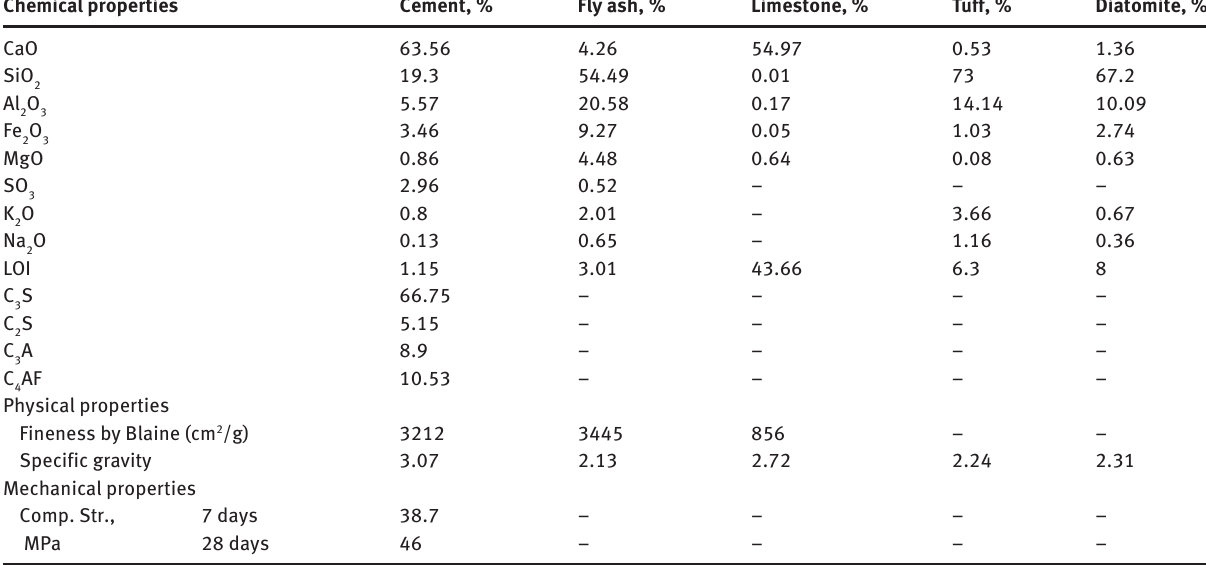
Table 1 Characteristic properties of cement, fly ash, limestone powder, tuff, and diatomite. – , not measured